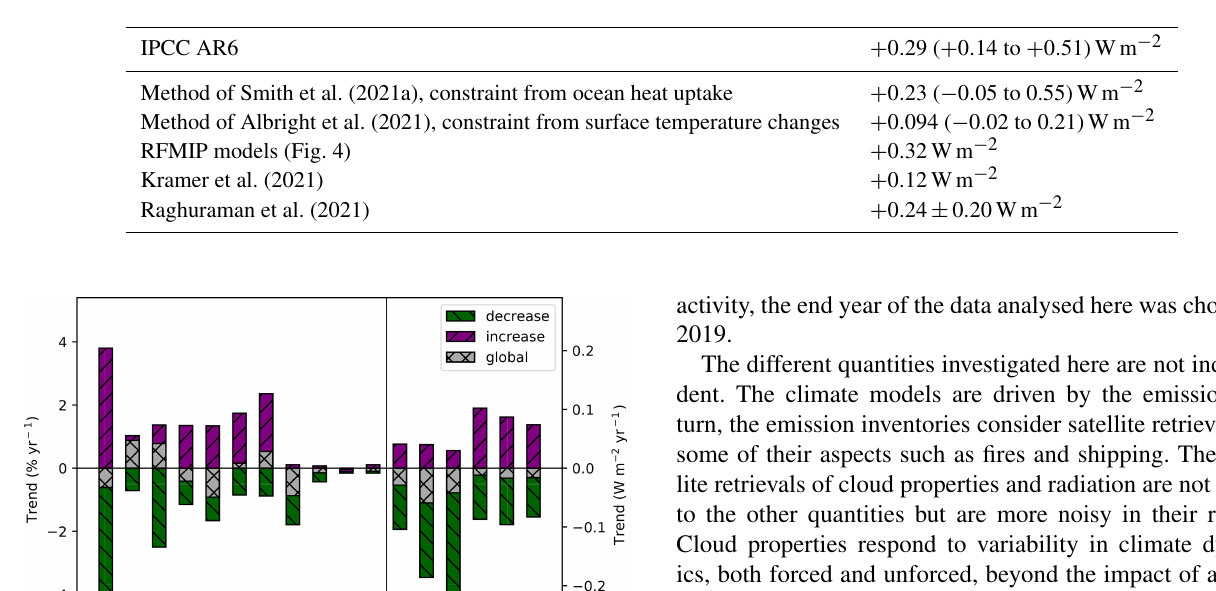
Table 2. Estimates of ERFaer change between 2000 and 2019. The 5% to 95% uncertainty ranges are provided. Kramer et al. (2021) assess radiative forcing (RF) due to aerosols and use the period 2003–2018; Raghuraman et al. (2021) use the period 2001–2019.